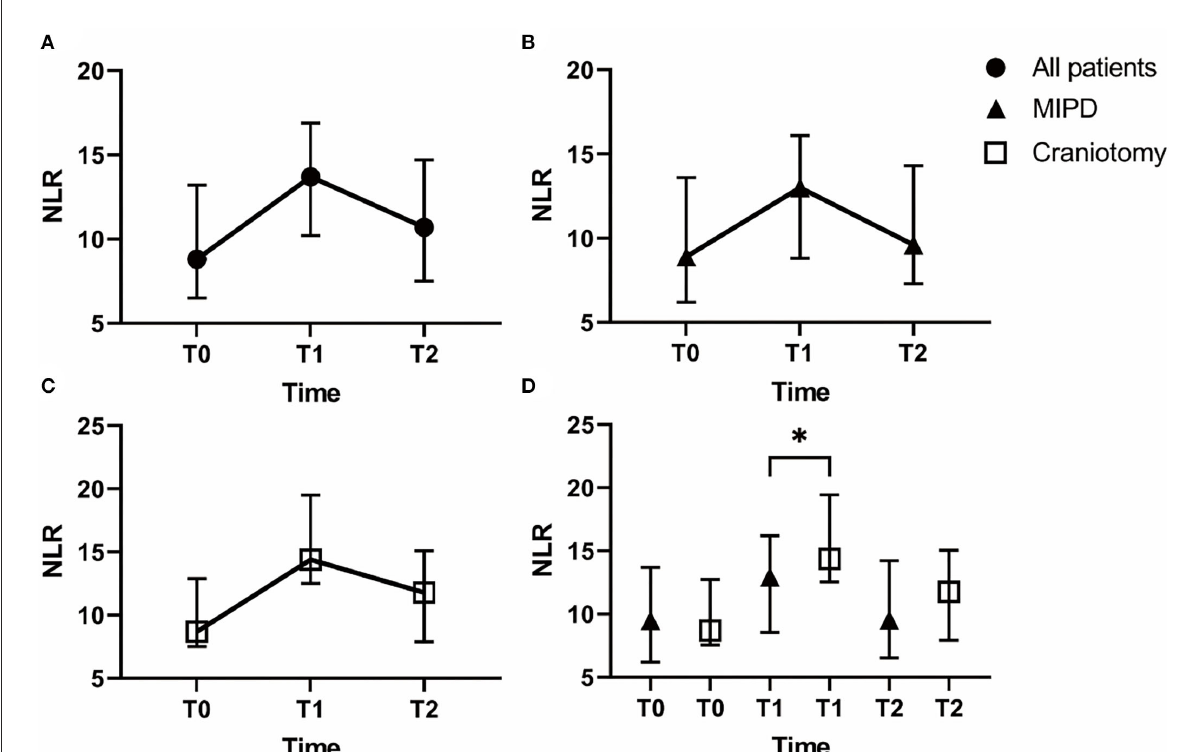
FIGURE1 The median neutrophil-to-lymphocyte ratio (NLR) value over time between patients with a different surgical approach. The NLR of different time points in all patients (A) , in the MIPD group (B) and in the craniotomy group (C) . The difference of NLR between the MIPD group and the